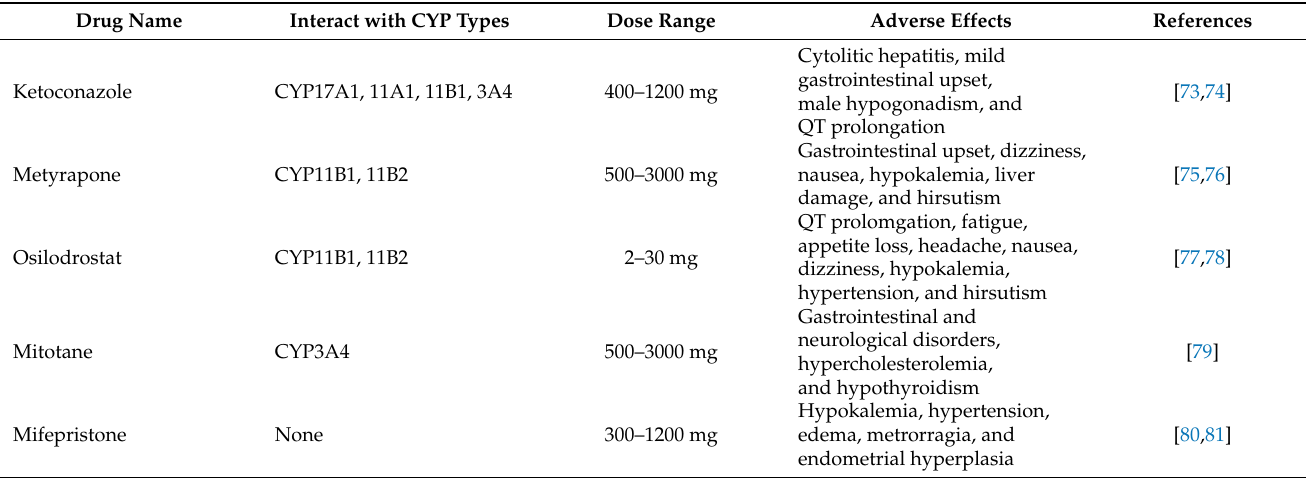
Table 1. Characteristics of drugs used for targeted adrenal gland therapy. CYP, cytochrome